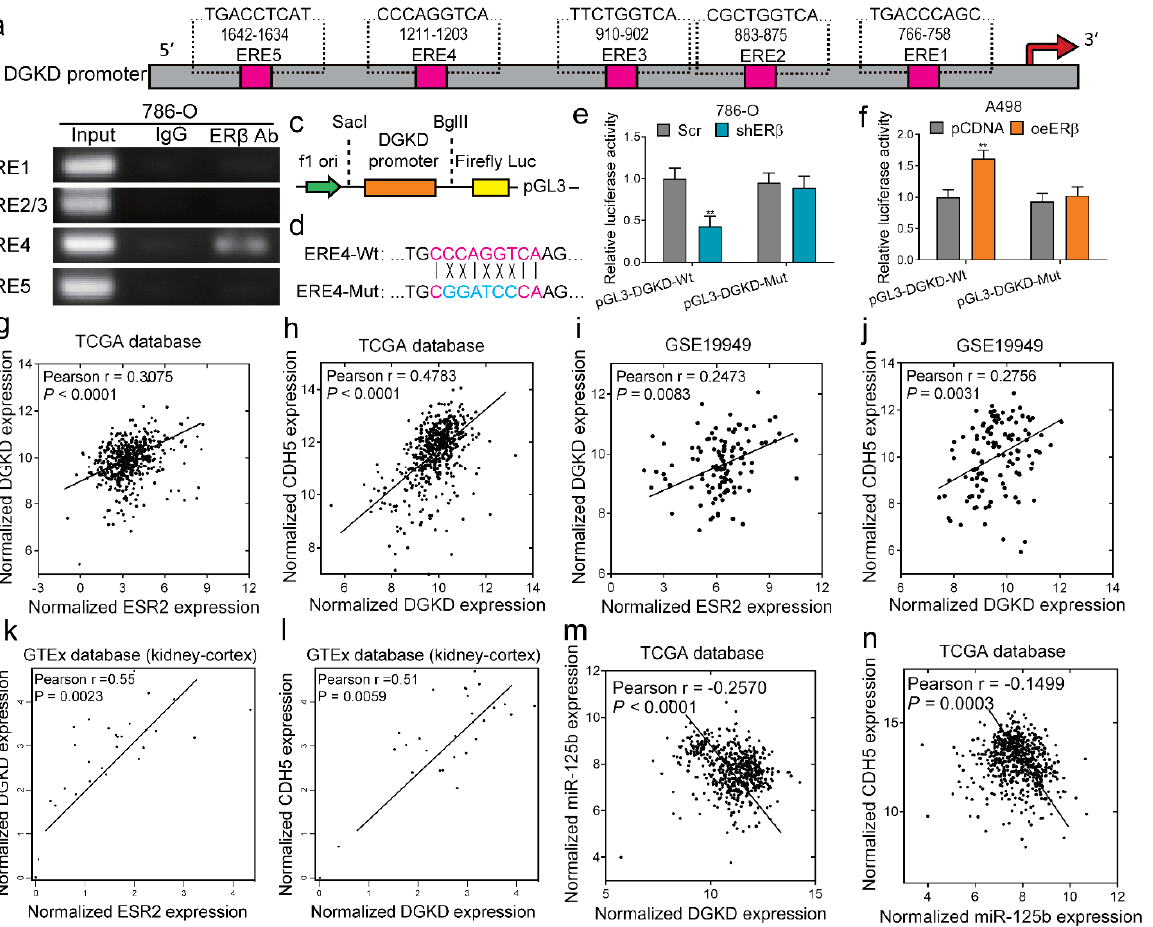
nor oeER β could change the luciferase activity, indicating that ER β modulated the DGKD whereas the sunitinib plus shcircDKGD combo treatment suppresses angiogenesis and mRNA/circRNA expression via binding to this ERE4 on its promoter. VM simultaneously.